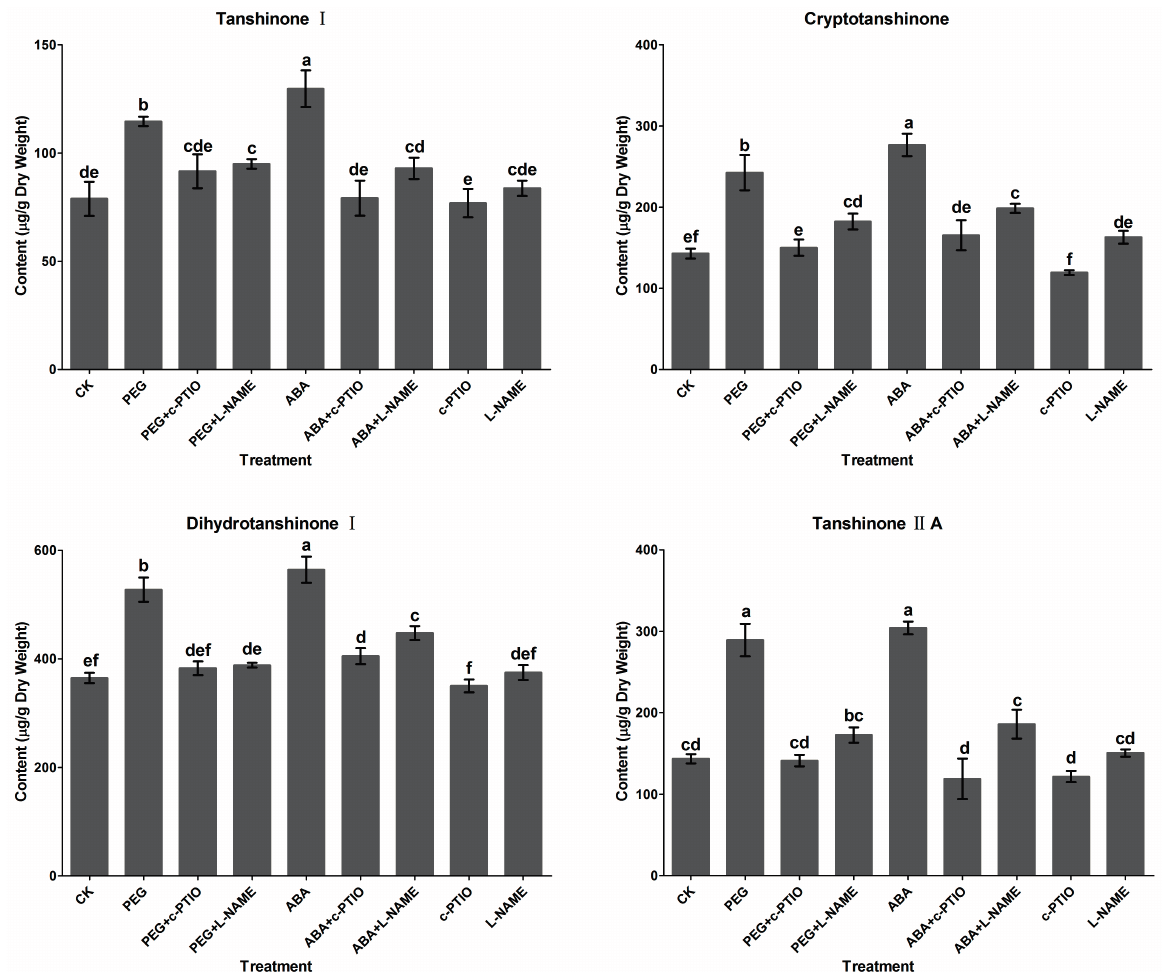
Figure 2. Effects of L -NAME (200 µM) and c-PTIO (200 µM) on PEG and ABA-induced tanshinone production in S. miltiorrhiza hairy roots. CK, the control; PEG, polyethylene glycol, 2% (W/W); ABA, abscisic acid, 200 µM; L -NAME: N ω -nitro- L -arginine methyl ester, 200 µM; c-PTIO, 2-(4-Carboxyphenyl)-4,4,5,5-tetramethylimidazoline-1-oxyl-3-oxide, 200 µM. Different letters (a, b, c, d, e and f) indicate significant difference at p ≤ 0.05. Means ± standard deviation (S.D.) ( n = 3) are